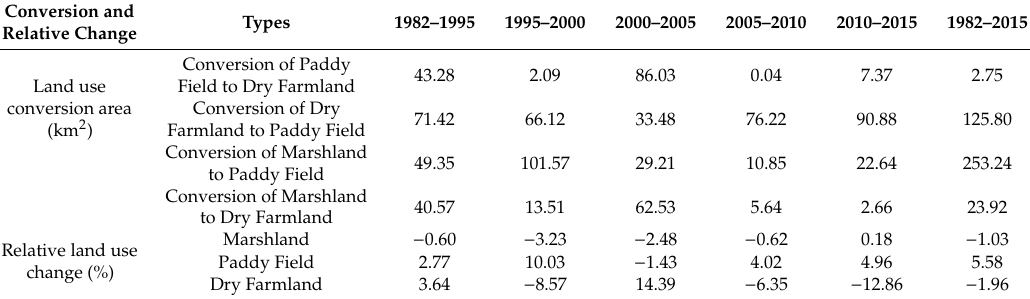
Figure 1. Spatial distribution of land use in the Xiangkai Lake area from 1982 to 2015. Table 3. Conversion and relative change of land use over di ff erent